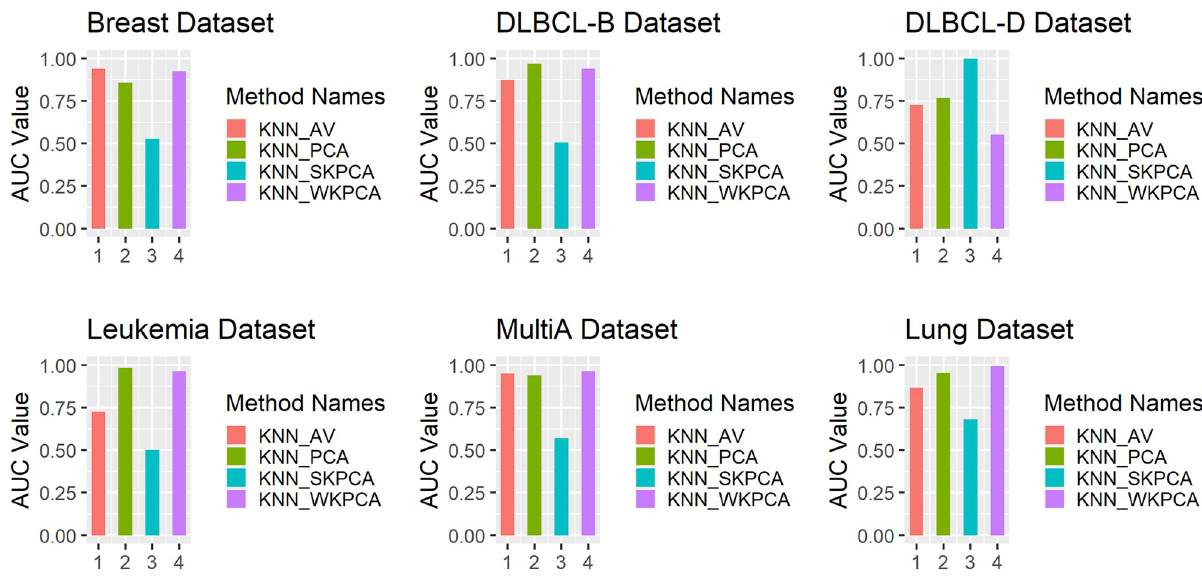
Fig 5. Comparison of the KNN_AV, KNN_PCA, KNN_SKPCA and KNN_WKPCA method AUC values.